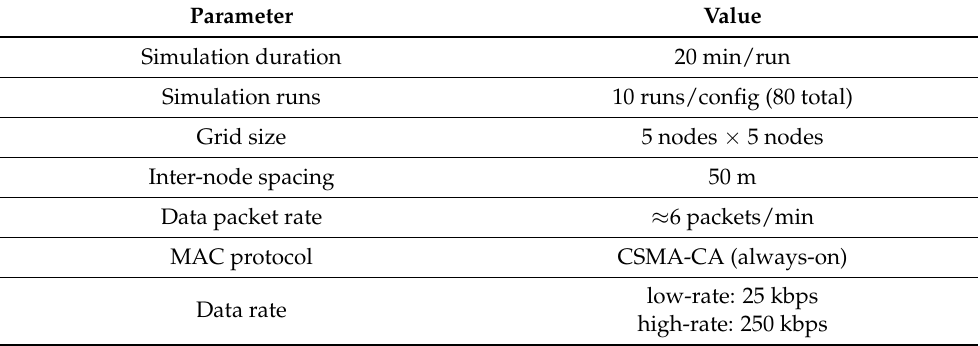
Table 3. Overview of common simulation parameters across different Objective Function (OF) and/or interface-type